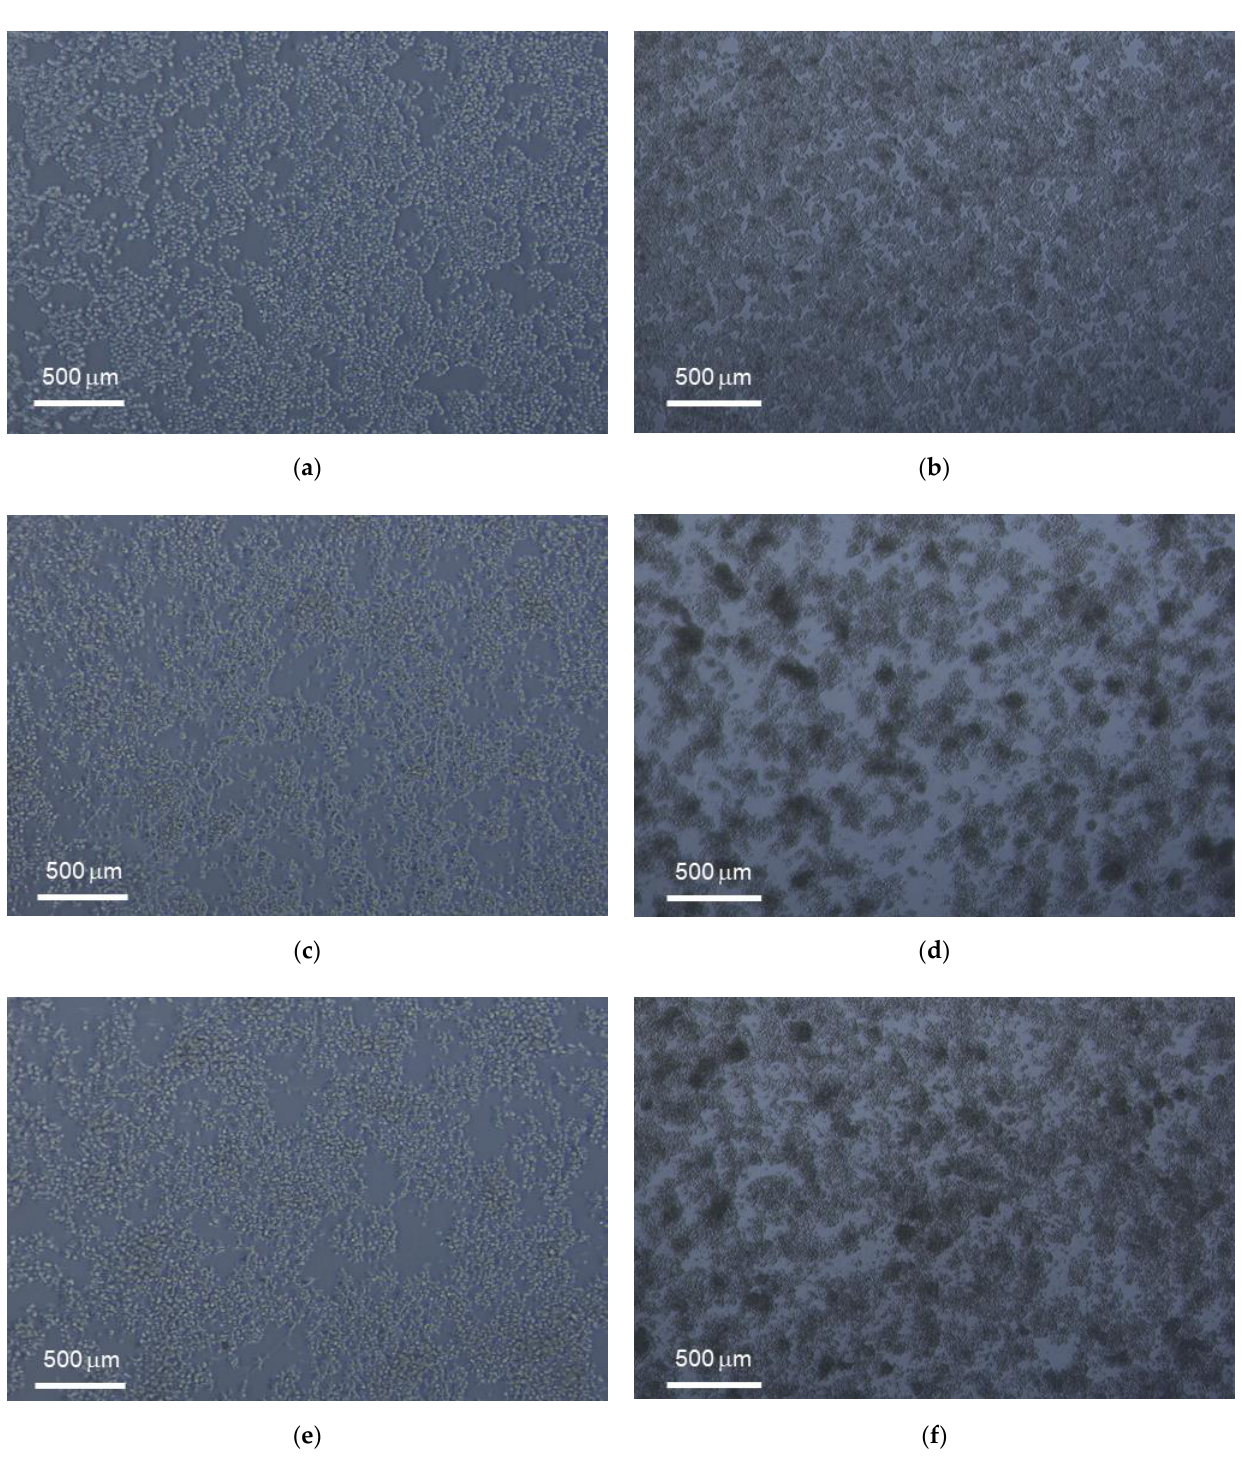
Figure 5. Morphology of (left) HeLa and (right) RAW 264.7 cells exposed to 50 µg/mL after 24 h of culture with untreated, UC n and UC@CB[7] nanoparticles ( a , c , e and b , d , f , respectively).